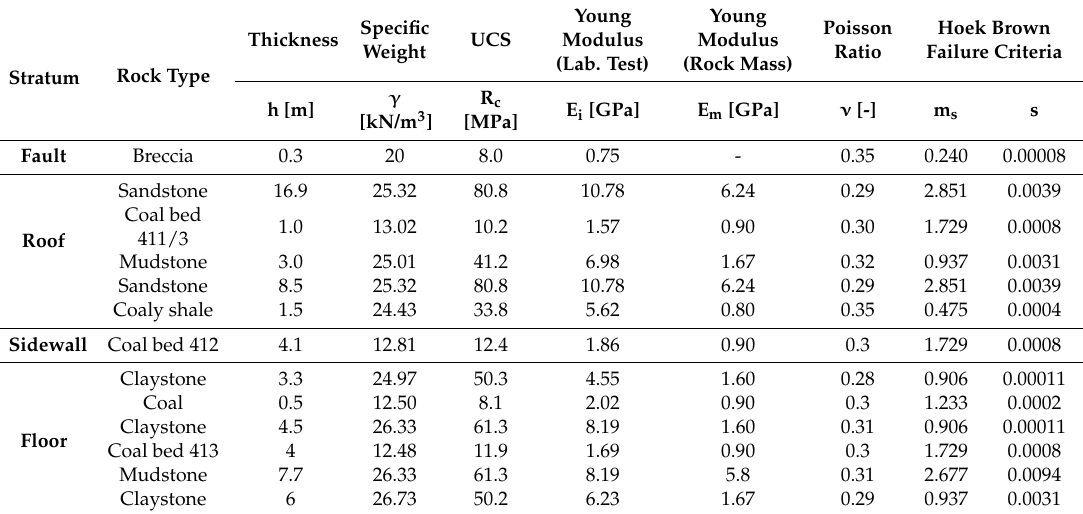
Table 3. Rock mass parameters in the numerical